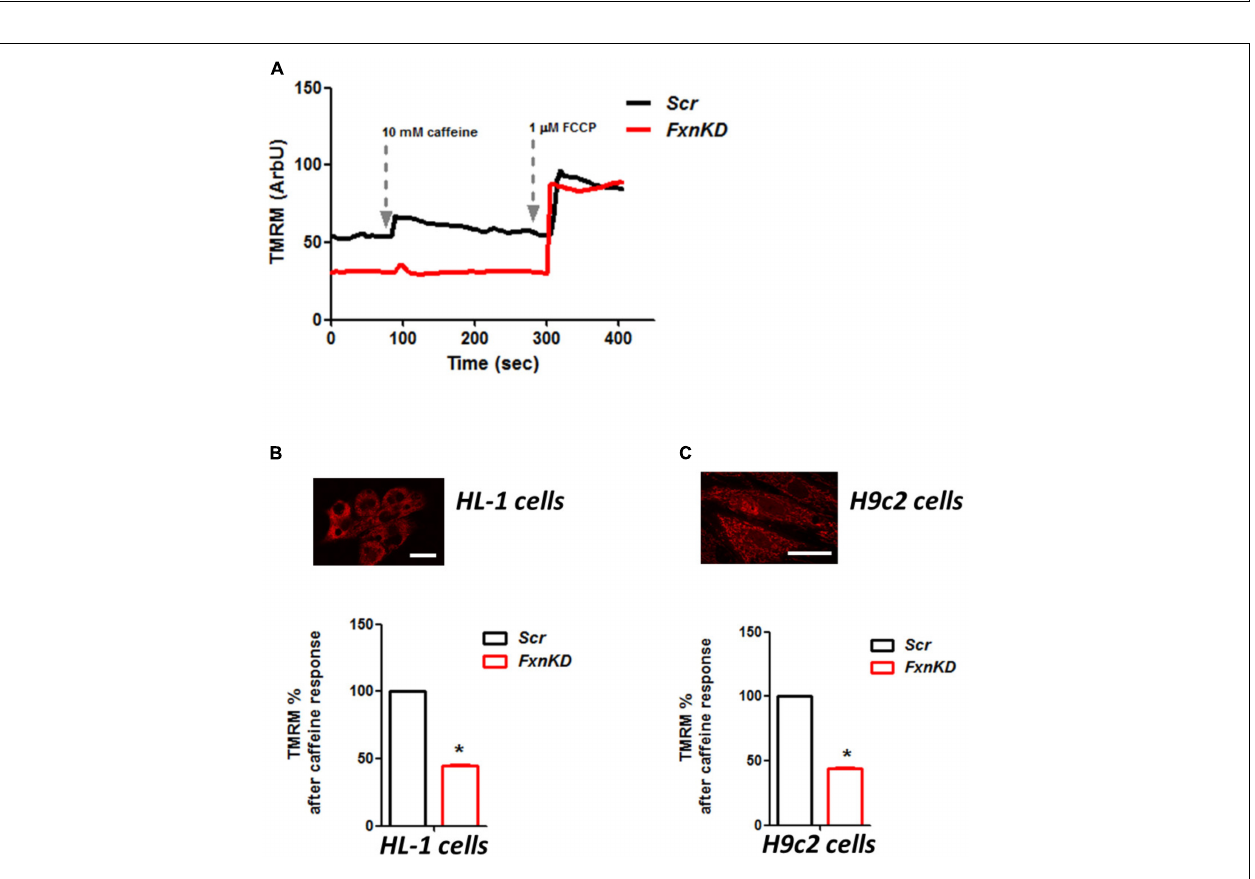
Frontiers in Cellular Neuroscience | www.frontiersin.org